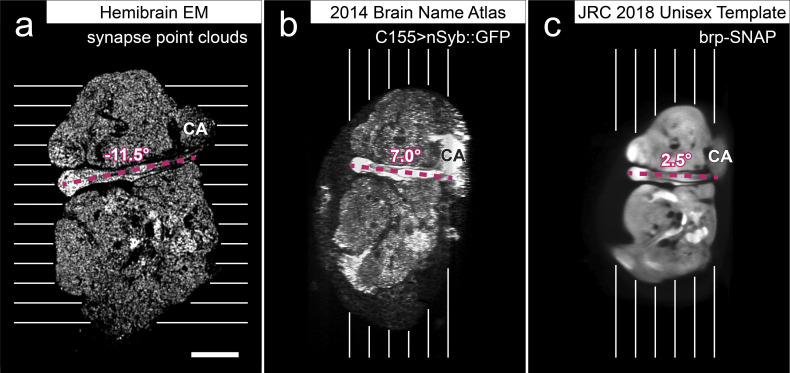
Comparison of the size and orientation of brain images.Sagittal section images at the plane of the mushroom body pedunculus are shown. Parallel lines indicate the direction of serial sectioning. Purple dotted lines indicate the axes of the pedunculus to show the sample orientation. Numbers indicate the angles of the pedunculus axes relative to the horizontal axis. Scale bar: 50 μm for all images. CA: calyx of the mushroom body. Panel (a) Hemibrain EM image stack. Grayscale indicates the density of the points of the presynaptic T-bars (point clouds). (b) Confocal light microscopy image stack provided by the Insect Brain Name Working Group (Ito et al., 2014), of a female brain mounted in 80% glycerol after antibody labeling. Presynaptic sites are labeled by GFP fused with the synaptic vesicle-associated protein neuronal synaptobrevin (nSyb), driven by the pan-neuronal expression driver line elav-GAL4 C155. (c) JRC2018 Unisex brain template (Bogovic et al., 2020), which is an average of 36 female and 26 male brains mounted in DPX plastic after dehydration with ethanol and clearization with xylene. Presynaptic sites are labeled with the SNAP chemical tag knock-in construct inserted into the genetic locus of the active zone protein bruchpilot (brp). The relative sizes of the brains, measured as the height along the lines that are perpendicular to the pedunculus axes, are 100:83:70 for (a), (b), and (c). These differences in size and orientation must be taken into account when comparing the sections and reconstructed neurons of the hemibrain EM and registered light microscopy images.